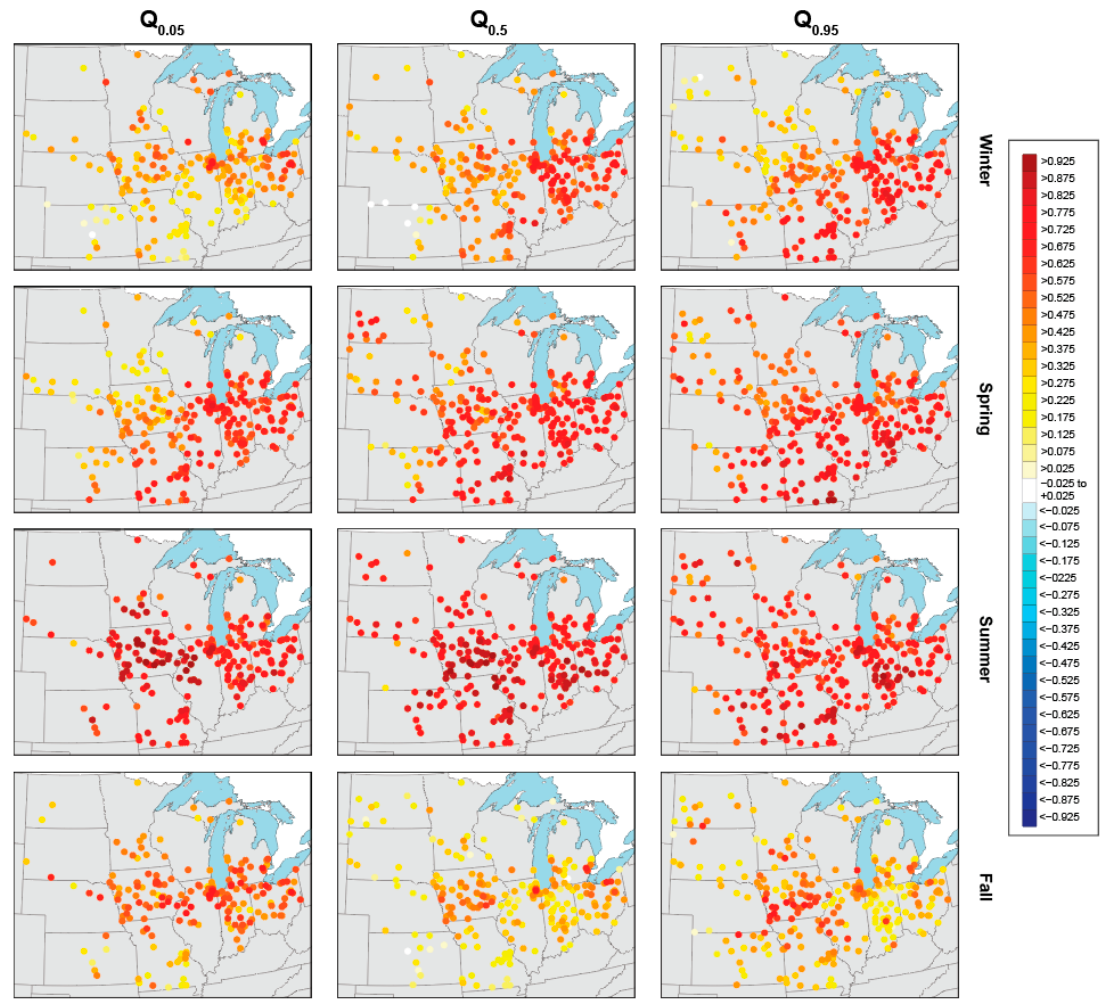
Figure 7. Correlation coefficient for the best-fitting model at each site. Each panel indicates the correlation coefficient between the best model’s median and observations, as indicated in Figure 5, by flow quantile and season. The legend indicates the value of the correlation coefficient ( R ) ranging from blue ( − 1) to red (1), with values centered around 0 shown in white ( − 0.025 to +0.025). The fits for the best models at each site are shown in the Figure S2. For comparison, Figure S6 shows the same information as Figure 7 but computed with Spearman’s rho instead of Pearson’s correlation coefficient R (nonparametric equivalent).